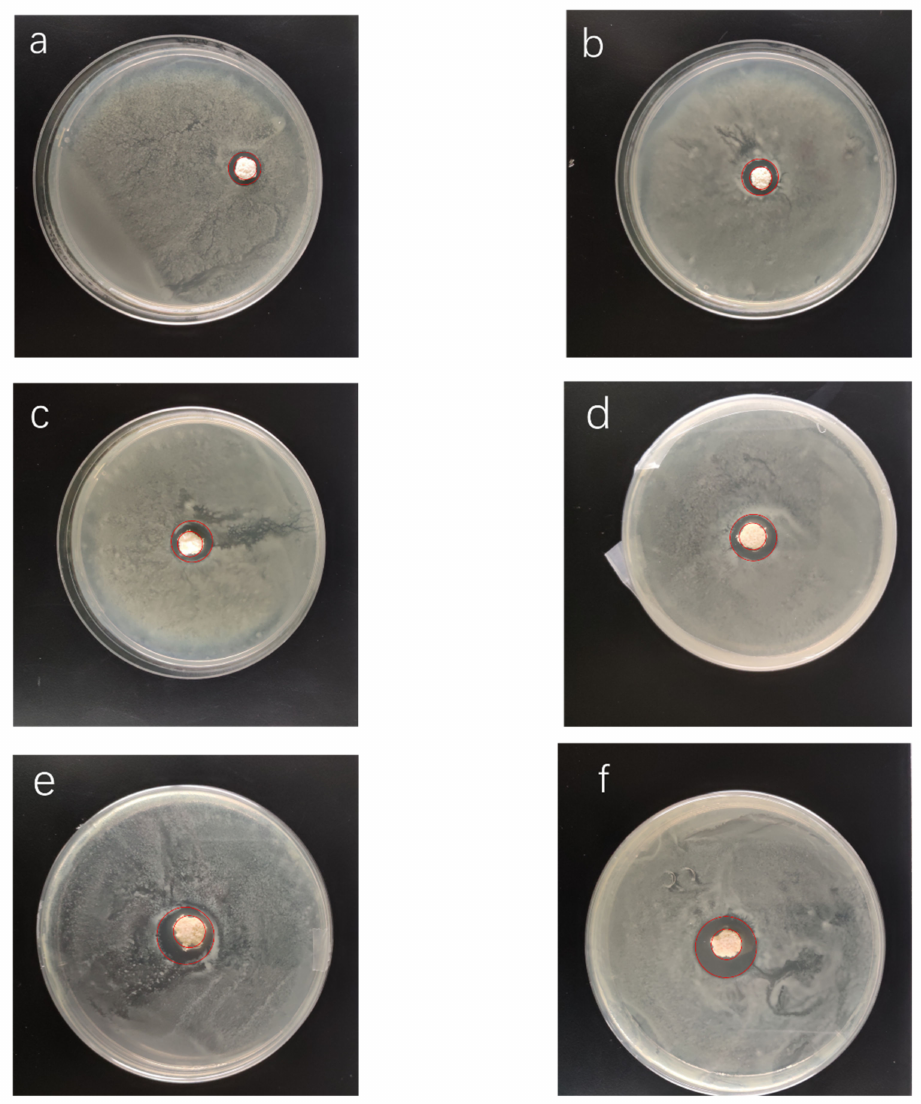
Figure 11. Inhibition zone against E. coli of chitin–NRLF composites. ( a ) pure NRLF; ( b ) NRLF–1 phr chitin; ( c ) NRLF–2 phr chitin; ( d ) NRLF–3 phr chitin; ( e ) NRLF–4 phr chitin; ( f ) NRLF–5 phr